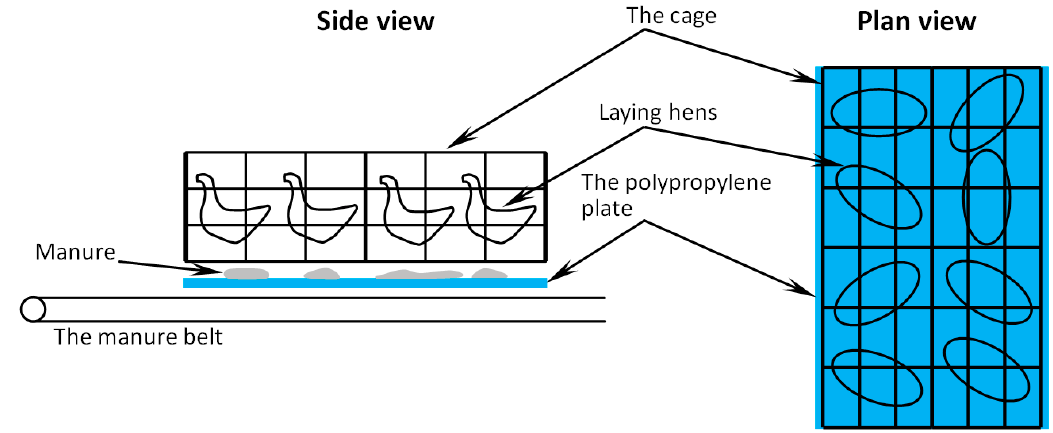
Figure 1. Schematic drawing of the size and placement of the polypropylene plate. The plate length is 860 mm, and the plate width is 680 mm.